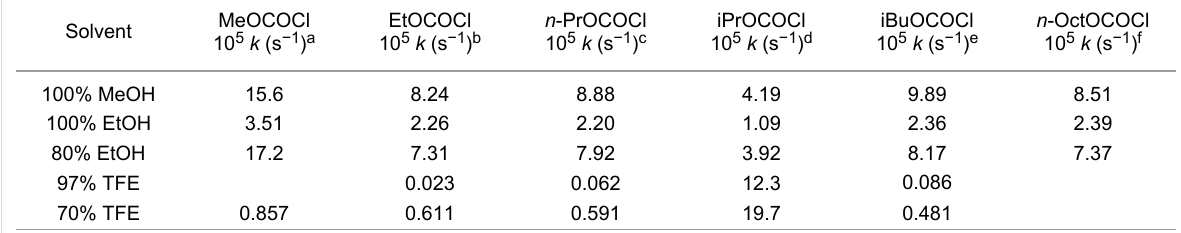
Table 4: A comparison of the specific rates of solvolysis of MeOCOCl, EtOCOCl, n -PrOCOCl, iPrOCOCl, iBuOCOCl, and n -OctOCOCl in common solvents at 25.0 °C.